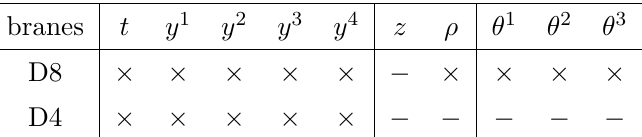
Table 1 . The brane picture underlying the 5d N = 2 SCFT de(cid:12)ned by the D4-D8 system. The system is BPS = 4 and the AdS 6 (cid:2) S 4 vacuum is realized by a combination of (cid:26) and z . the circle. Performing a T-duality along the circle we obtain a four-brane in type I’ on the interval S 1 = Z with two O8 planes in the (cid:12)xed points. Then the four-brane can 2